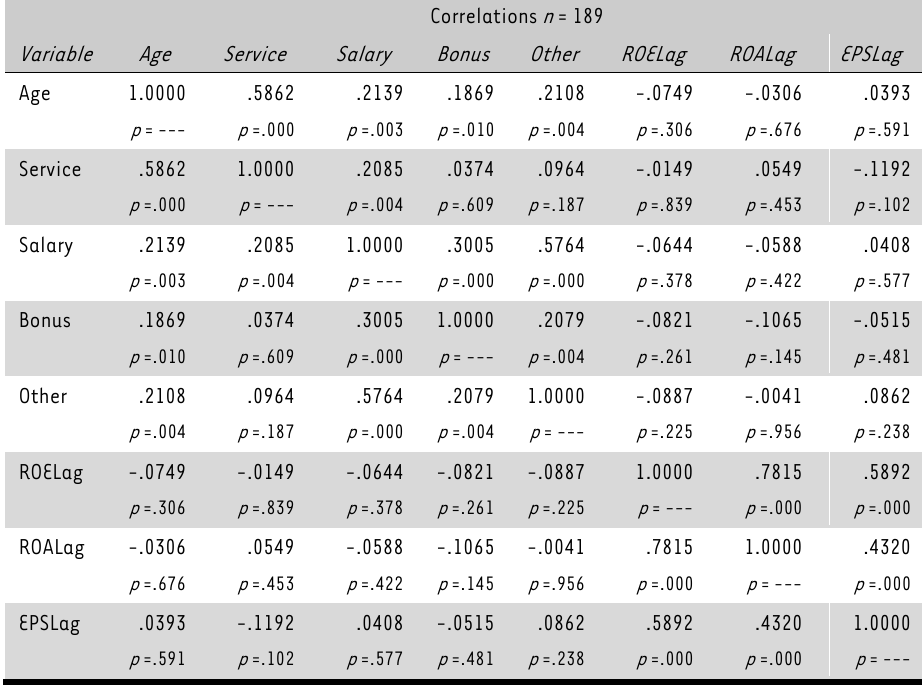
TABLE 13: A correlation matrix using lagged performance measures Correlations n = 189 Variable Age Service Salary Bonus Other ROELag EPSLag 1.0000 .5862